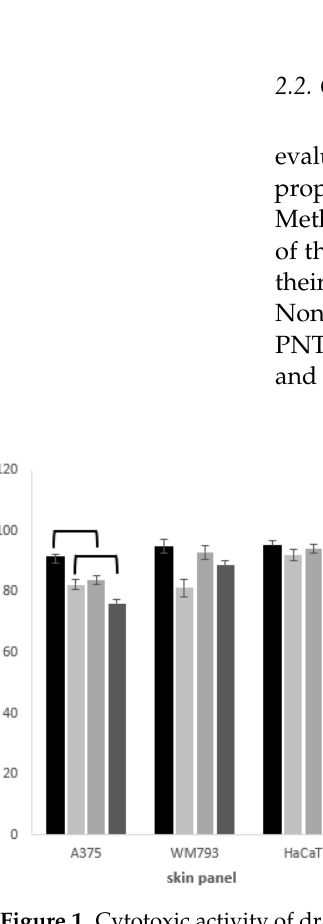
Figure 1. Cytotoxic activity of dragon fruits from Israel (DI) and Thailand (DT) on normal and cancer cells in skin, prostate and gastrointestinal panel. Cells were incubated with fruit water (W) or methanol (M) extracts (0.5 mg/mL). Cell viability was expressed as % of control (untreated) cells (n = 3). Values that are significantly different are combined with upper black line ( p < 0.05).